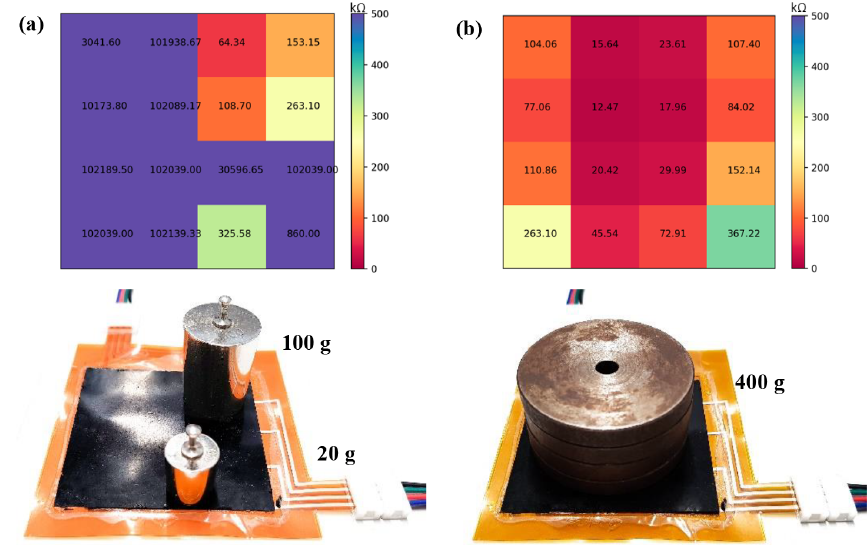
Figure 9. Pressure distribution measurements of different weights and positions of test loads measured with a 4 × 4 sensor